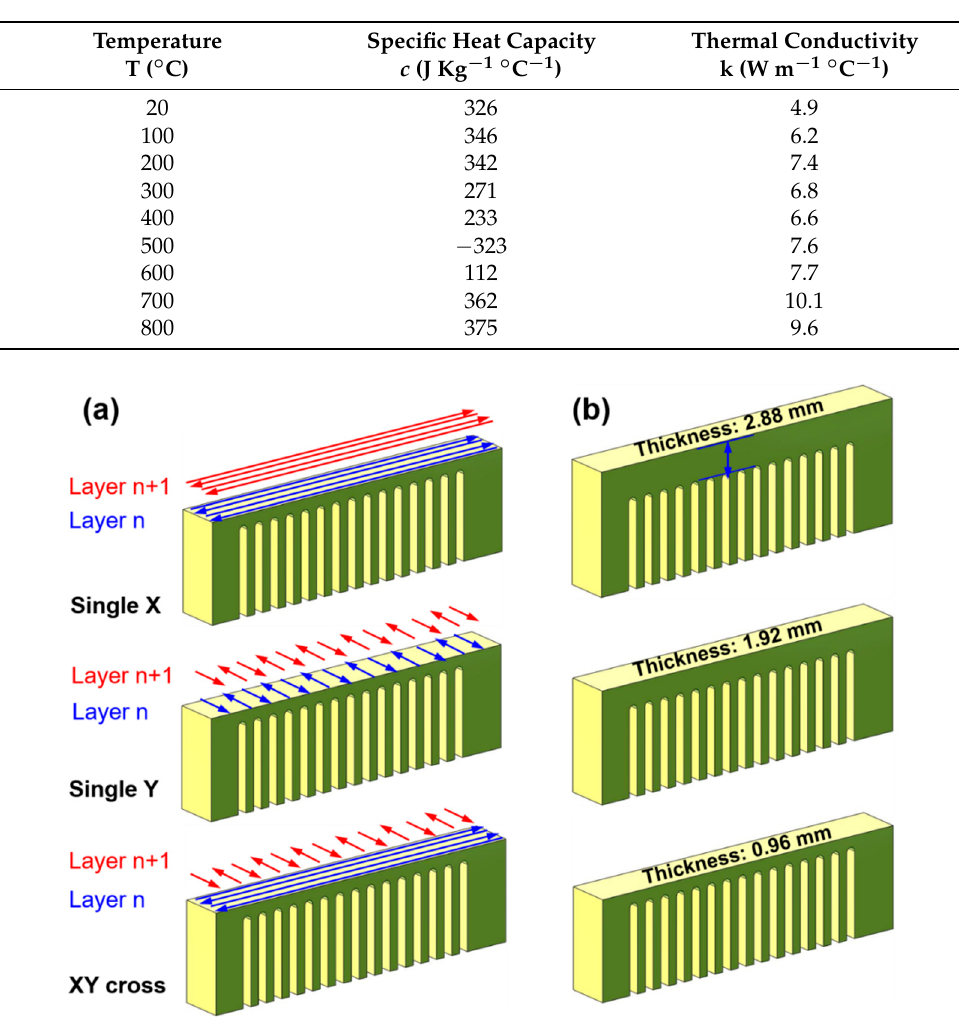
Table 2. Thermal physics parameters of the Zr-based amorphous alloy.